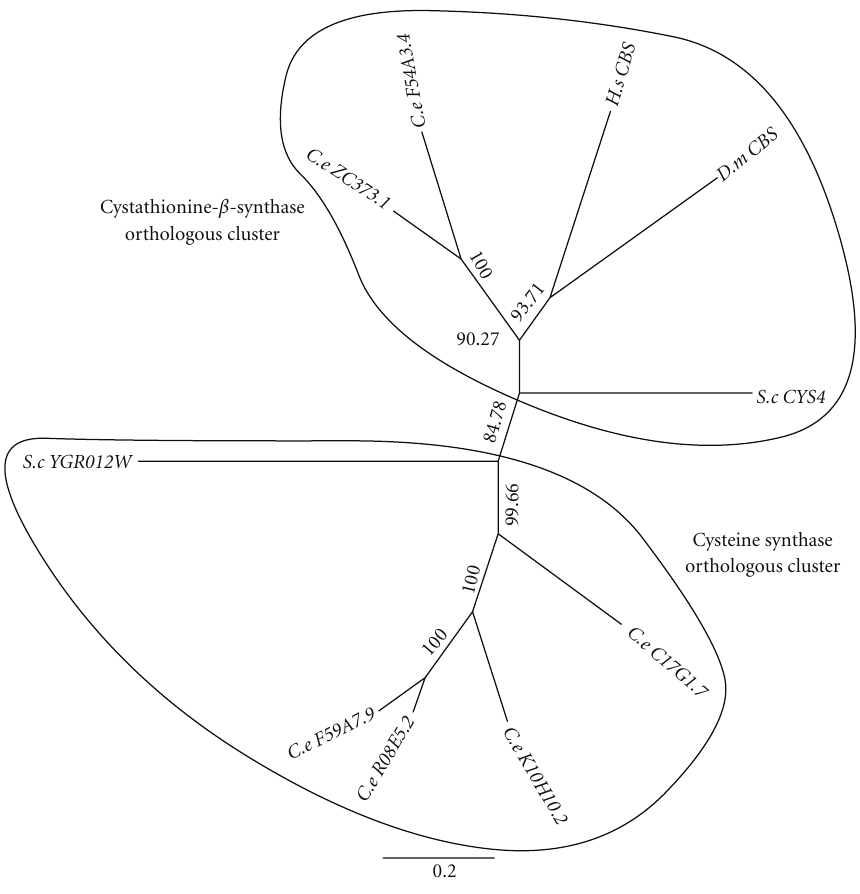
Figure 2: Phylogenetic tree analysis of cystathionine- β -synthase (CBS) and putative cysteine synthase (PCS). A blast (blastp) search of known Homo sapiens ( H.s ) proteins was undertaken against three di ff erent species, Saccharomyces cerevisiae ( S.c ), Drosophila melanogaster ( D.m ), and Caenorhabditis elegans ( C.e ) in the Genbank database. Identified sequences with significant expected value ( ≤ 1E − 10) were used to generate a multiple sequence alignment (MSA) via ClustalW 2.1. The MSAs were then trimmed and used to produce an unrooted phylogenetic tree with 10,000 boostraps via Geneious